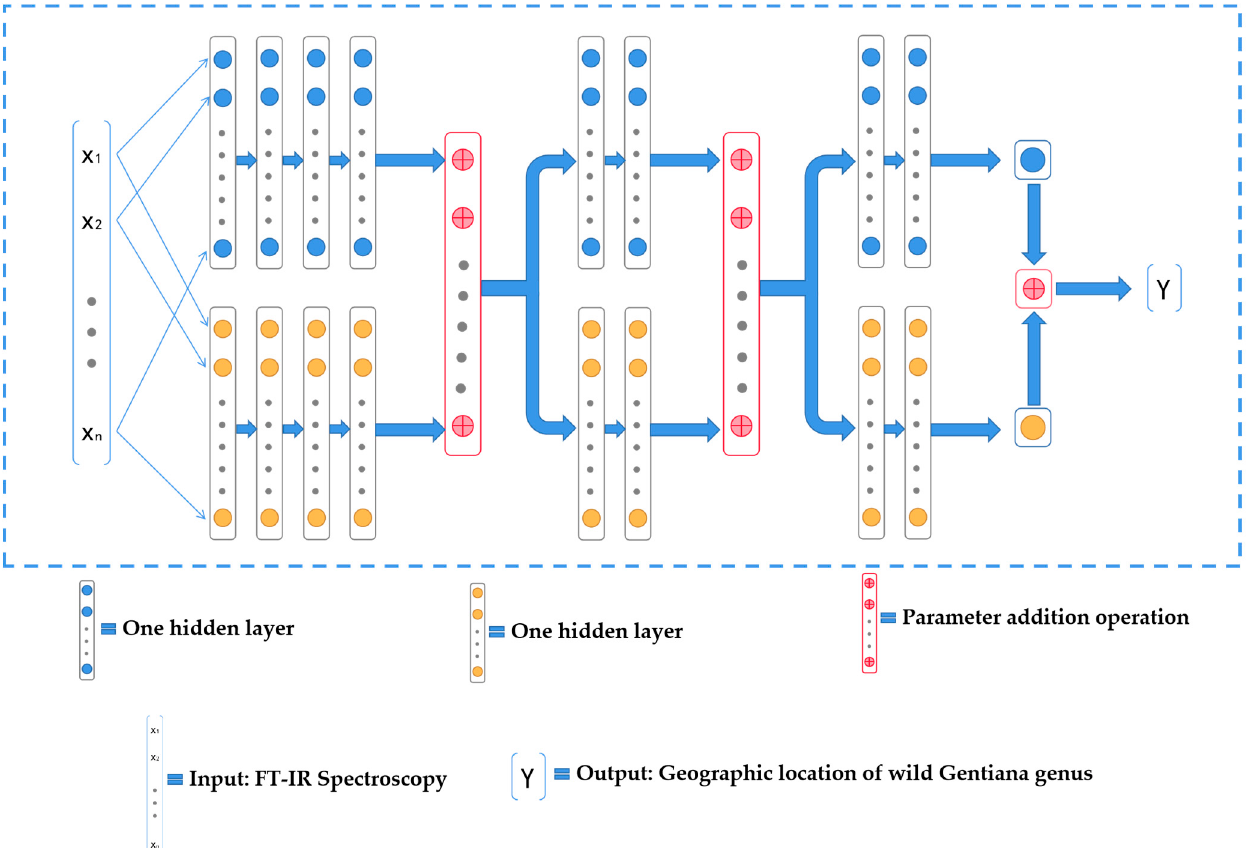
Figure 9. The structure of the neural network Double-Net.